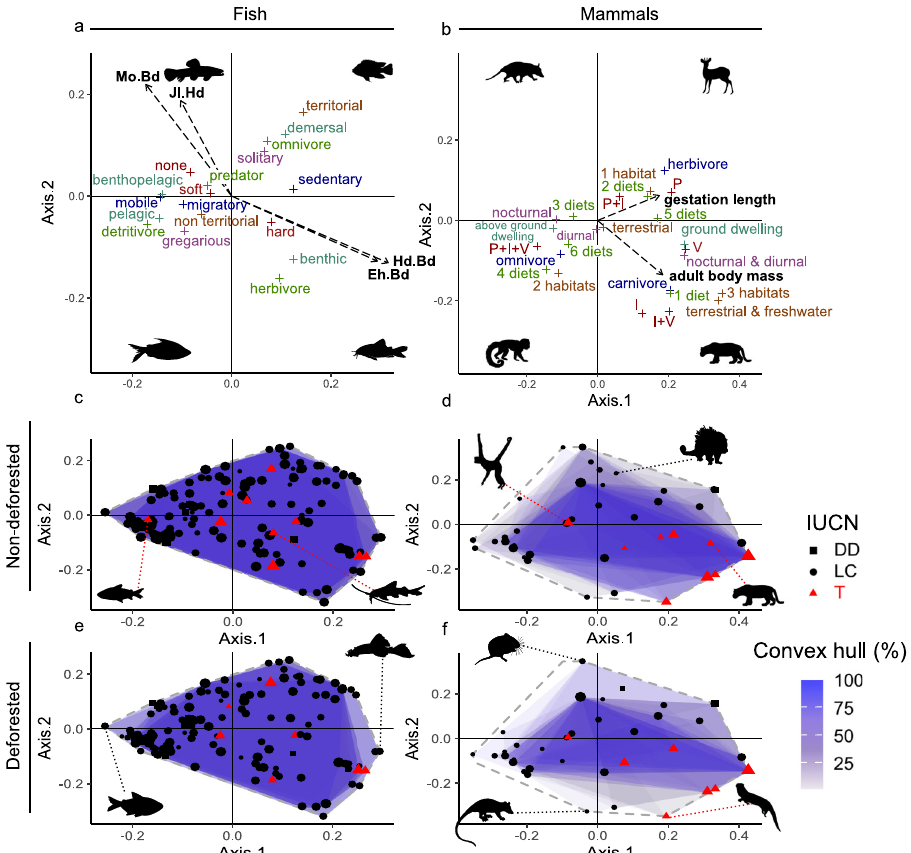
Fig. 5 Functional spaces for fi sh and mammals in non-deforested and deforested sites. Loadings of functional traits on two fi rst axes of principal coordinate analysis for fi sh ( a ) and mammals ( b ). Only signi fi cant and most highly correlated quantitative traits with axes are represented with black dotted lines. Qualitative traits are displayed in colour. For each site, the functional space of each community is represented by a convex hull. Convex hulls of each site were superimposed for each category ( fi sh non-deforested, 34 sites; mammals non-deforested, 35 sites; fi sh deforested, 30 sites; mammals deforested, 39 sites). Blue shade intensity increases with the percentage of superimposed convex hulls from 0% (white) to 100% (dark blue). The Grey dotted line represents global functional space considering all species in both non-deforested and deforested habitats. Species symbol size is proportional to species occurrence percentages. In IUCN lists, DD is Data-De fi cient species; LC is Least Concern species, and T is Threatened species. Sites were considered non-deforested for percentage deforestation <0.33% (see methods) within the identi fi ed relevant spatial extent (30 km). Silhouettes illustrate functional characteristics of species in each quadrant ( a , b ), emblematic species only found in non-deforested sites (or rarely occurring in deforested sites for spider monkey) ( c , d ), and extreme functional strategies ( e , f ). See Supplementary Data 1 for species occurrences and coordinates in functional spaces. For b , P (Plants in the diet), I (Invertebrates in the diet), V (Vertebrates in the diet), diet (Number of dietary categories), habitat (Number of habitat layers) (Supplementary Table